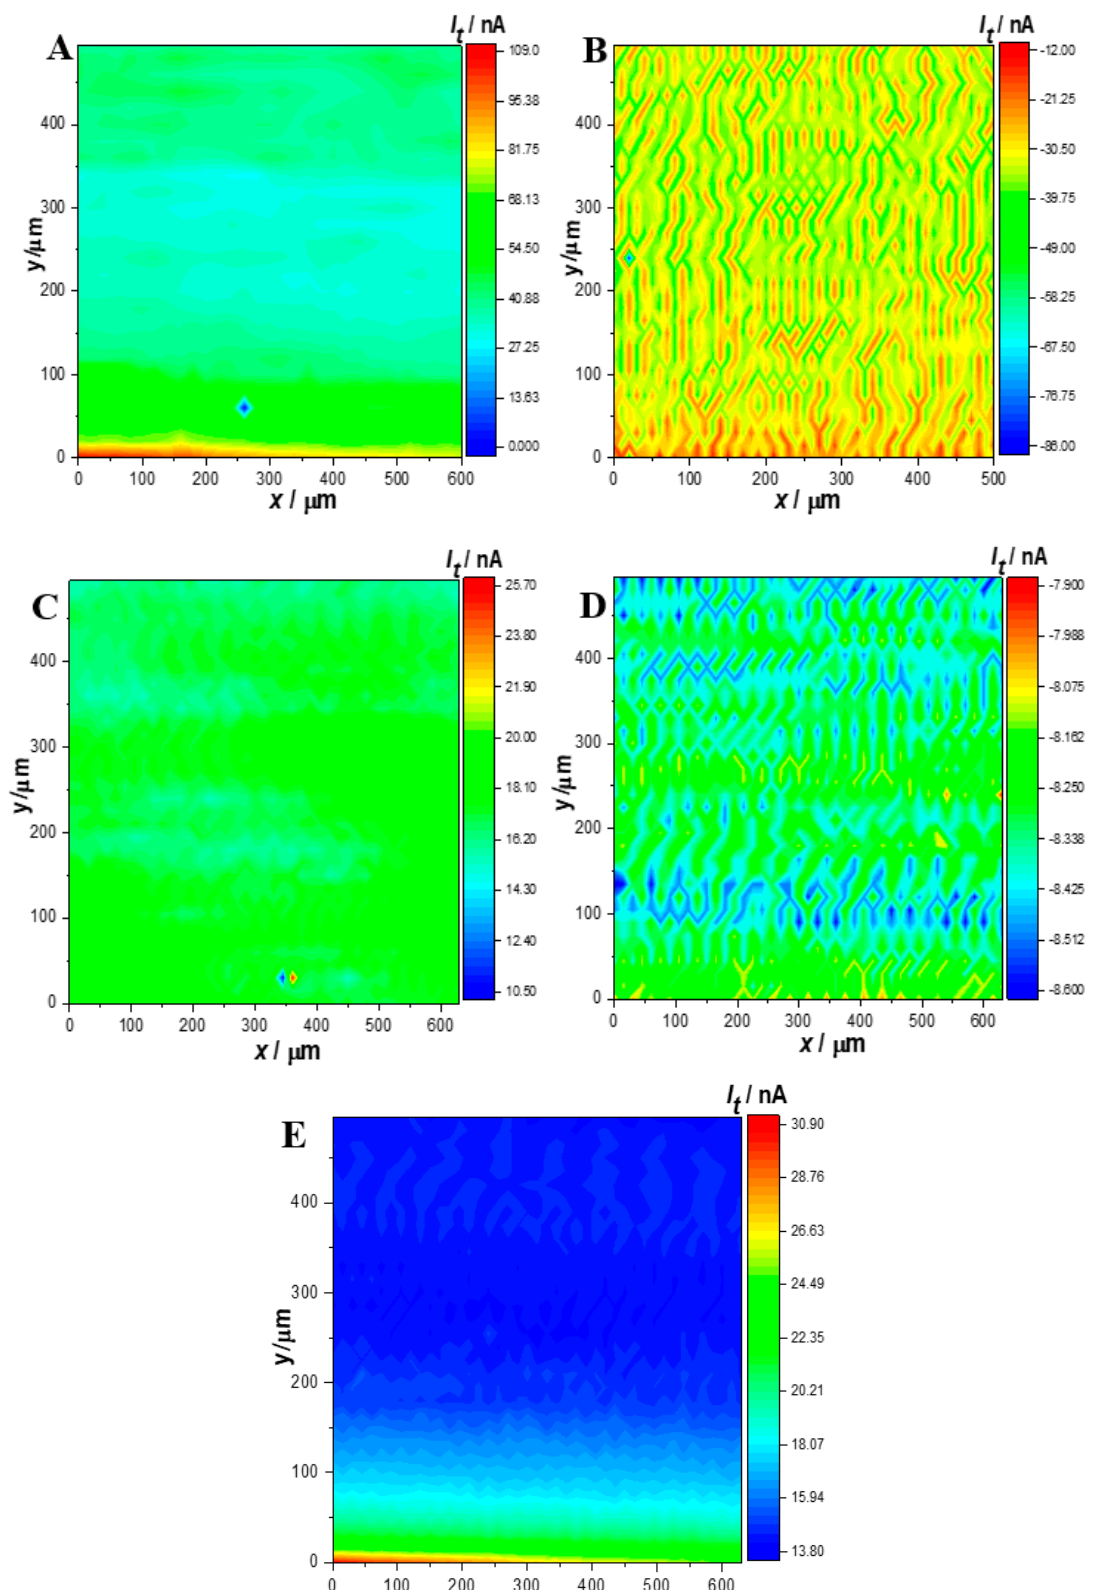
Figure 7. SECM 2D maps obtained with the tip biased at +600 mV Ag/AgCl and the sample at the open circuit potential: ( A ) uncoated substrate; ( B ) Ni–P layer; ( C ) CNT-0.25; ( D ) CNT-0.50; ( E ) CNT-1.0. Electrolyte: 0.1 M NaCl solution at room temperature.